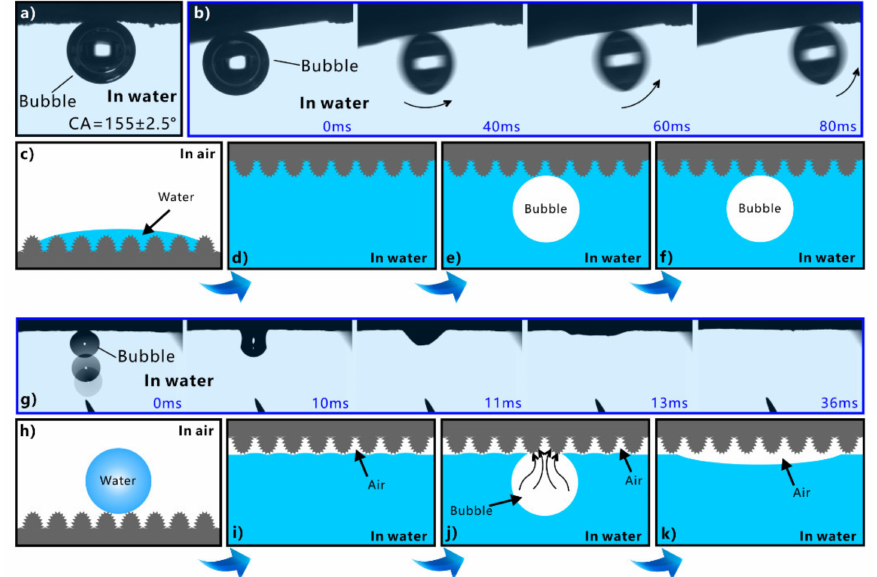
Figure 25. Superaerophobicity of fish scales and superaerophilicity of lotus leaves in water. ( a ) An air bubble on the surface of a fish scale underwater. ( b ) Bubble rolling away on the fish scale in water. ( c – f ) Schematic formation mechanism of the underwater superaerophobicity of fish scales: ( c ) water wetting the surface microstructures of fish scale in air, ( d ) immersion of the fish scale in water, ( e ) underwater bubble just contacting with the fish scale, and ( f ) after some time. ( g ) Process of a bubble touching the surface of a lotus leaf underwater. ( h – k ) Formation mechanism of the underwater superaerophilicity of lotus leaf: ( h ) water being repelled by the superhydrophobic microstructures of leaf surface, ( i ) lotus leaf in water, ( j ) releasing a bubble onto the lotus leaf in water, and ( k ) after some time. Reprinted with permission from ref. [46]. Copyright 2017, American Chemical